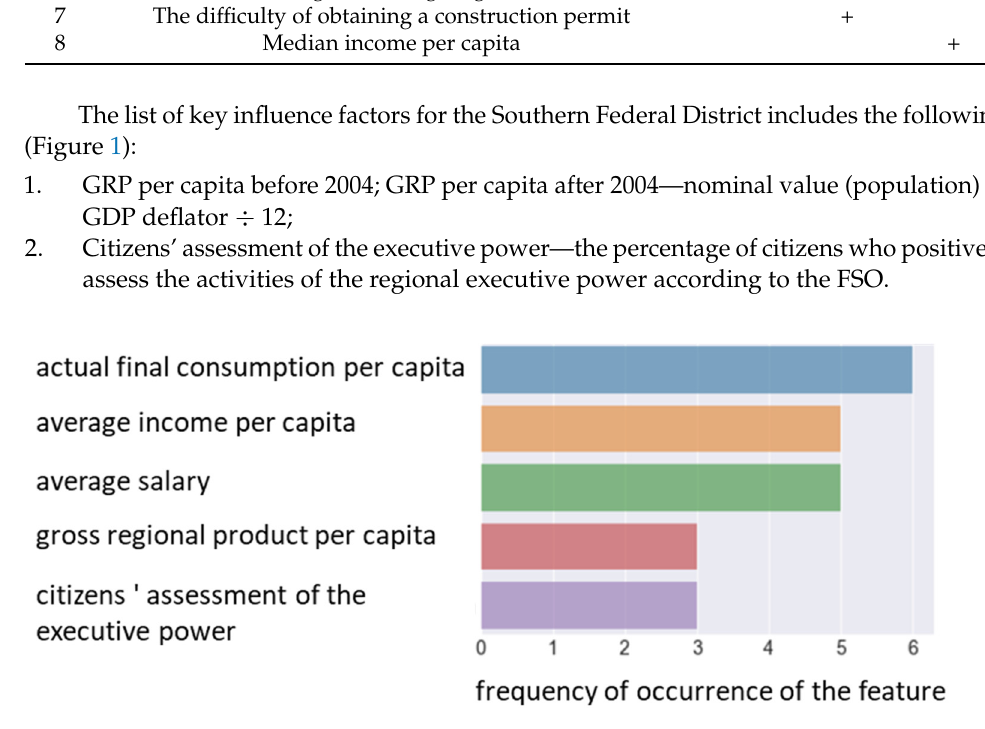
Figure 1. TOP 5 most common factors in the Southern Federal